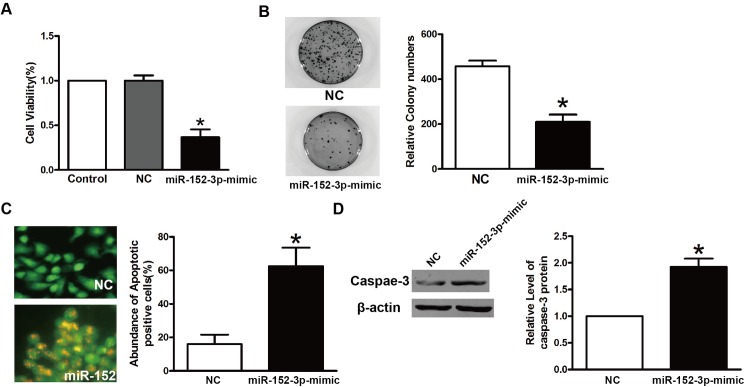
The mir-152-3p inhibits proliferation and colony formation of TPC-1 cells.A. The MTT assay of TPC-1 cells infected with the NC or mir-152-3p mimic. *P<0.05. B. The colony formation assay of TPC-1 cells infected with the NC or mir-152-3p mimic. top, representative images. Bottom(graph), colony numbers from three independent experiments. *P<0.05. C. The acridine range/ethidium bromide ratio was determined to characterize the apoptosis of TPC-1 cells. D. The expression of caspase-3 in TPC-1 cells after treatment with the NC or mir-152-3pmimic was determined by western blots. *P<0.05.